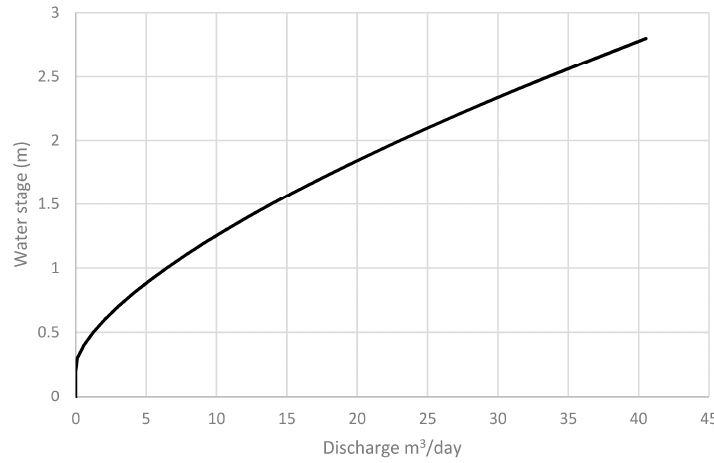
Figure 3. Modeled stage–discharge relationship for the treatment wetland. The wetland’s maximum stage is 1.5 m, which is set by the berm height.